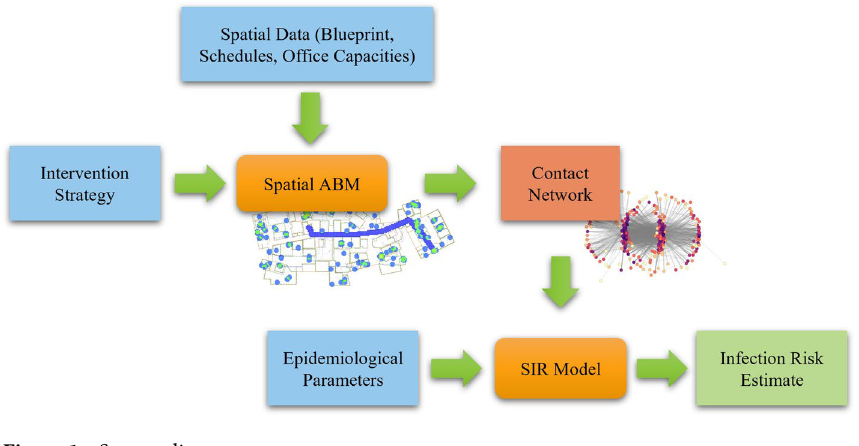
Figure 1. System